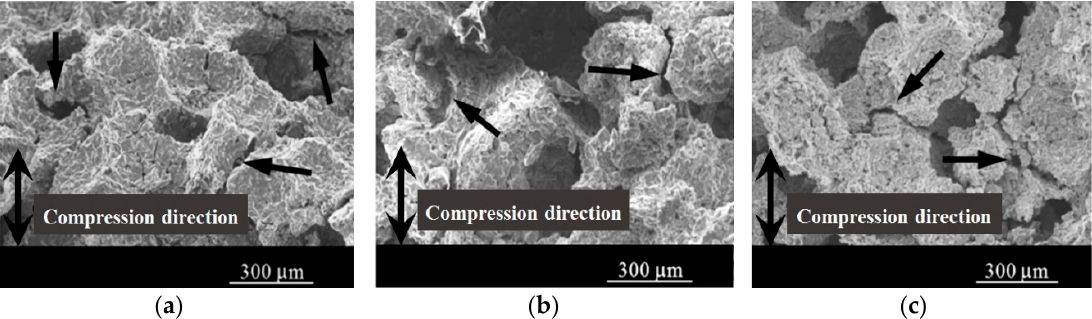
Figure 9. SEM images of compressed porous Ti samples with different porosities at ×100 magnification; ( a ) 57.6%, ( b ) 69.7%, and ( c ) 78.0%.